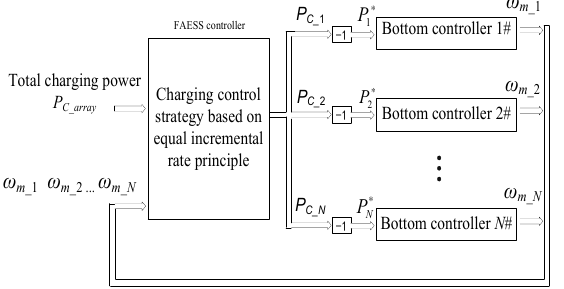
Figure 9. Implementation scheme of the charging coordination control of the flywheel array energy storage system (FAESS).